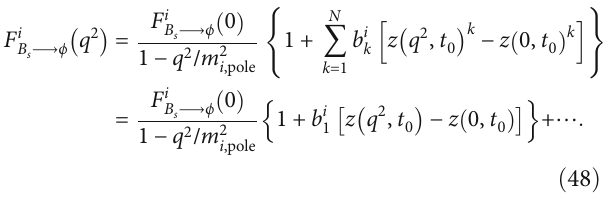
be taken in the same way as in Reference [94]: t 0 = t + ð 1 − ffiffiffiffiffiffiffiffiffiffiffiffiffiffiffiffiffi p 1 − t